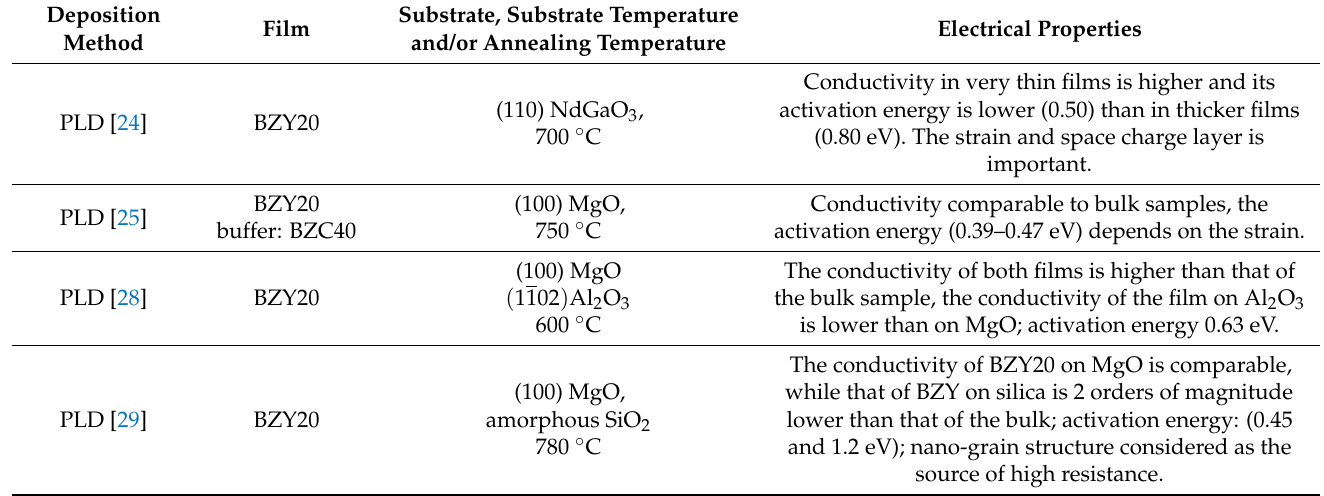
Table 1. Selected conditions of the films preparation and their electrical properties. BZY20 signifies BaZr 0.8 Y 0.2 O 3 − δ